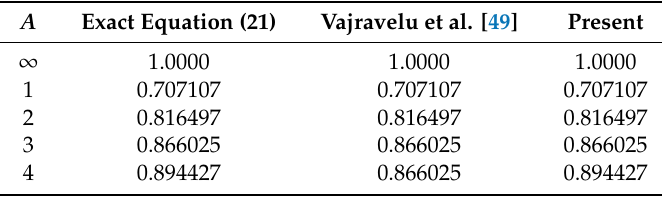
Table 1. Numerical values of − f (cid:48)(cid:48) ( 0 ) when β = N = Gr = M = 0. A Exact Equation (21) Vajravelu et al. [49] Present ∞ 1.0000 1.0000 1.0000 1 0.707107 0.707107 2